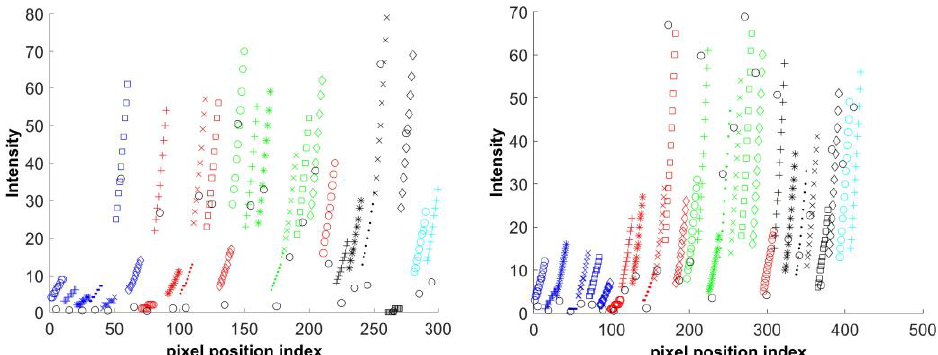
Figure 5. Two example results of the sensor irradiance 𝐸 𝑖 calculations according to Equation (7). Left : Teli dataset; right : SONY dataset. The black circles represent the estimated sensor irradiance 𝐸 𝑖 for the respective pixel position index of 𝑖 . Each set of ten or twelve intensity values for each pixel position; obtained from fill factor variation, are shown with certain color and shape respectively from Teli or SONY dataset.